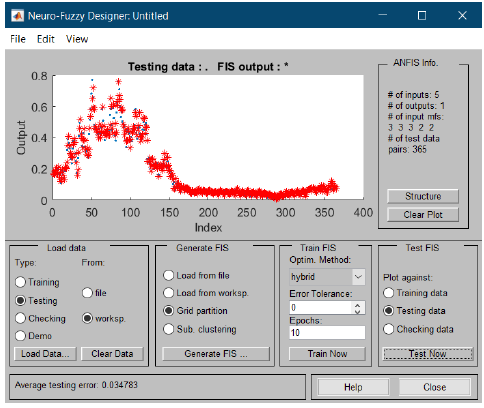
Figure 5. Screenshot of the testing data configuration.